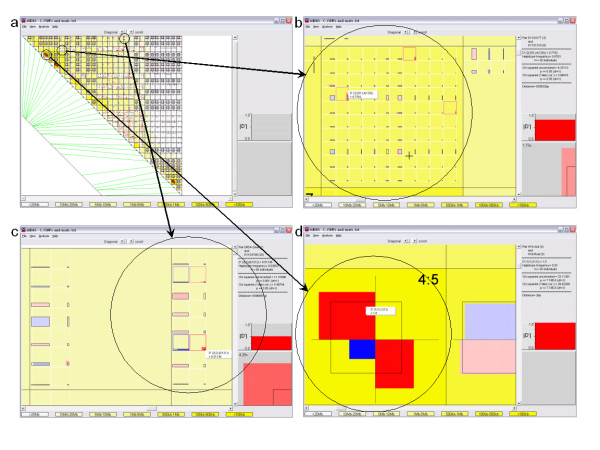
Screenshots of MIDAS. (a) A region of chromosome 11 showing 30 markers. Green lines indicate relative position of markers. Yellow intensity indicates distance between pairwise markers. Placing the mouse over a feature provides details. (b) A pairwise plot for two microsatellites (zoomed in). Significant results are boxed in red (D' ≥ 0) or blue (D'<0). Placing the mouse cursor over an allele pair provides details and statistics and also plots that pair at the bottom right of the screen. Magnitude of |D'| is also plotted (middle right). (c) A SNP/microsatellite pair (zoomed in). This is identical to the microsatellite/microsatellite plot, but with only two alleles in one dimension. (d) A SNP/SNP pair (zoomed in). The plot is oriented to place the most frequent alleles for both SNPs in the top left. Statistics can be observed by placing the mouse over an allele pair. For SNPs a magnified plot is not shown, but the |D'| graph is still used (middle right).